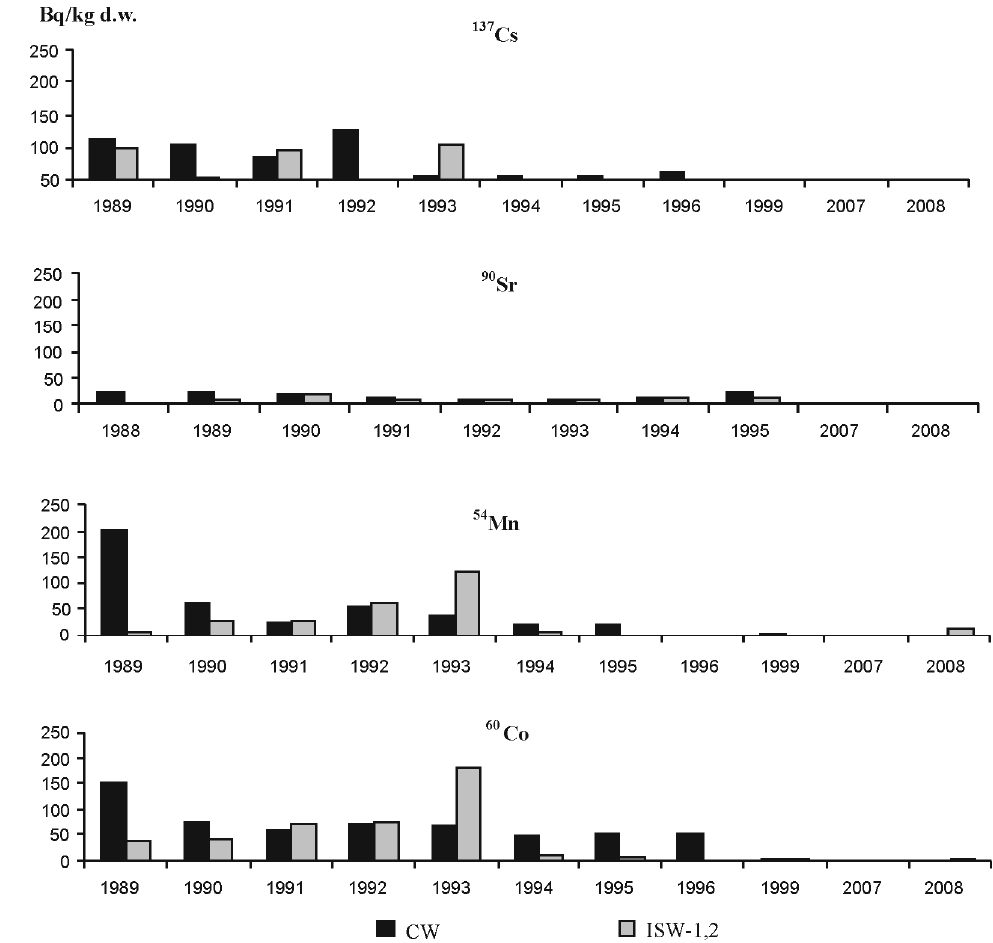
Fig. 3. Activity concentration of radionuclides in bottom sediment of the waste water discharge channels of the Ignalina